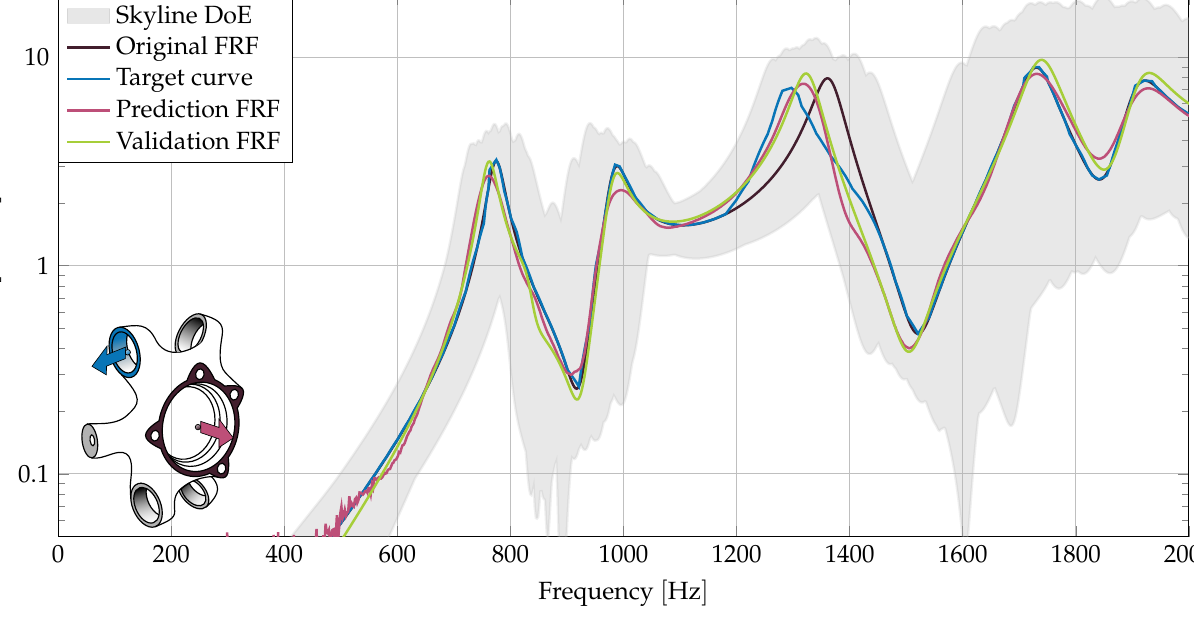
Figure 10. Optimization using a matching-curve to achieve an eigenfrequency reduction and an amplitude reduction at